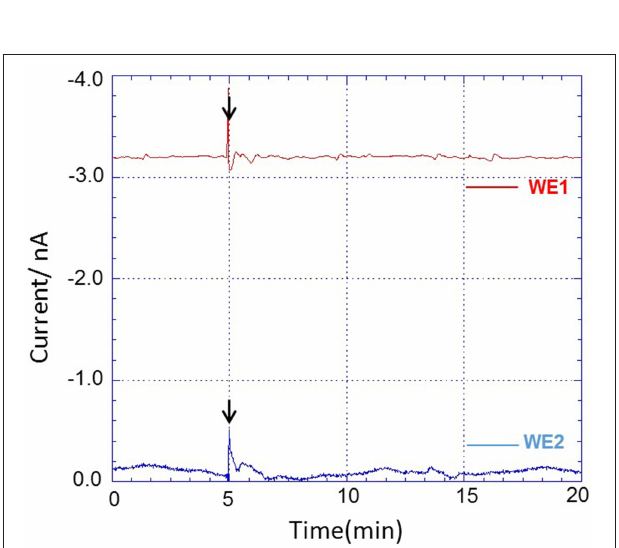
FIGURE 4 | (A) Amperometric response of standard H 2 O 2 solution in PBS in the concentration range of 1–4 nM. Addition of H 2 O 2 solution was done in real-time under continuous stirring condition and reduction current for H 2 O 2 was monitored using Os-HPR modified Au electrode. (B) , Calibration curve was plotted by taking an average of 50 s of the constant phase (as indicated in A , dotted lines) obtained after the addition of standard known concentration of H 2 O 2 .